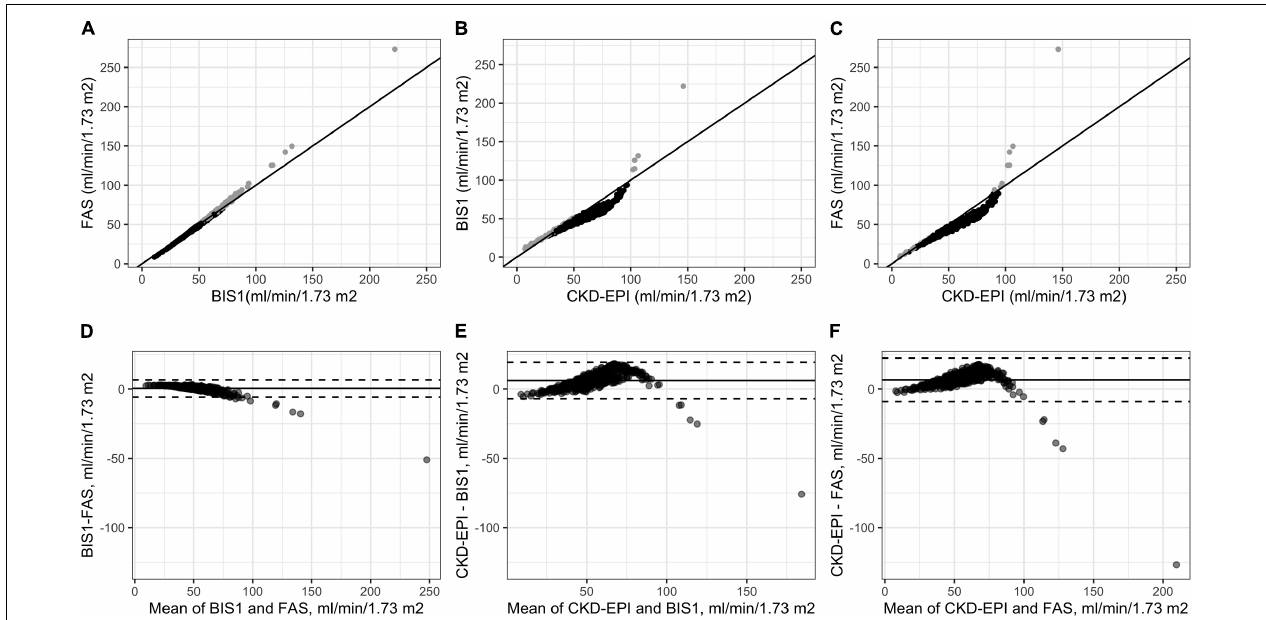
FIGURE 2 | Correlations among the three adopted eGFR equations (A–C) and Bland–Altman analysis (D–F) . Gray points in (A–C) indicate NH residents for which the difference between the estimates of GFR through the equation reported on the y -axis is higher than those reported on the x -axis values. Gray points in ( A–C) indicate NH residents for which the estimates of eGFR through the equation reported on the y -axis are higher than those reported on the x -axis; black points indicate NH residents for which the estimates of GFR through the equation reported on the y -axis is lower than those reported on the x